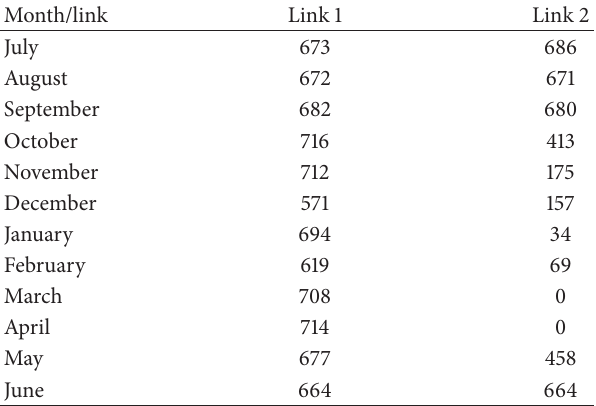
Table 3: Number of simulations performed in each month for each frequency (all 𝑀